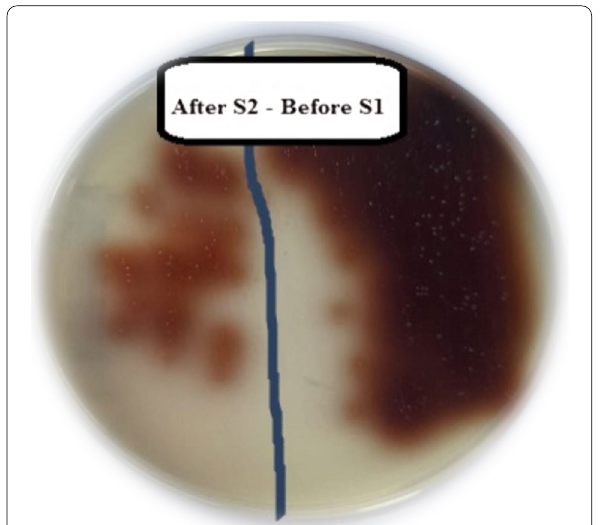
Fig. 5 Culture of S1 and S2 in AgNPs paste group